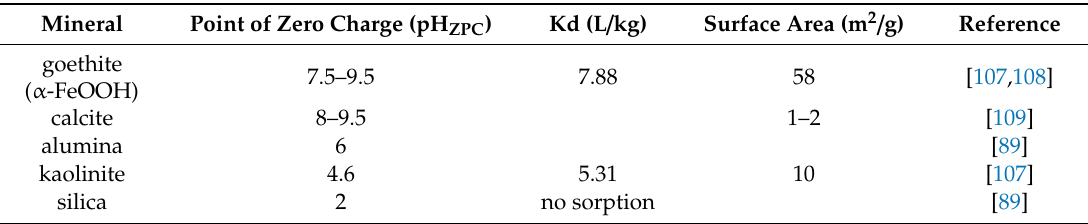
Table 5. Sorption coe ffi cients, surface area, and point of zero charge for mineral phases relevant to MAR. Minerals are listed in order of decreasing potential for sorption of